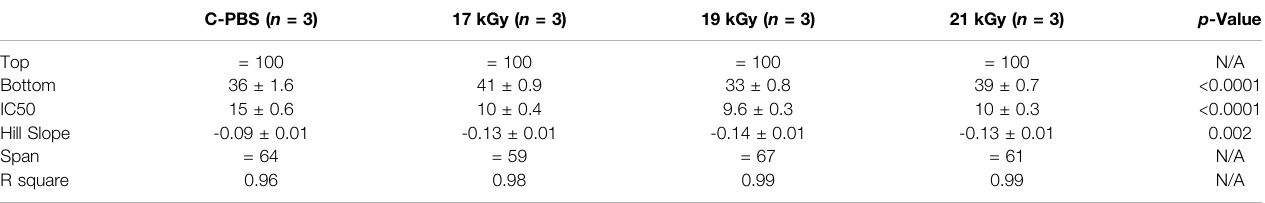
Data is reported as mean ± SE. Top value was constrained to